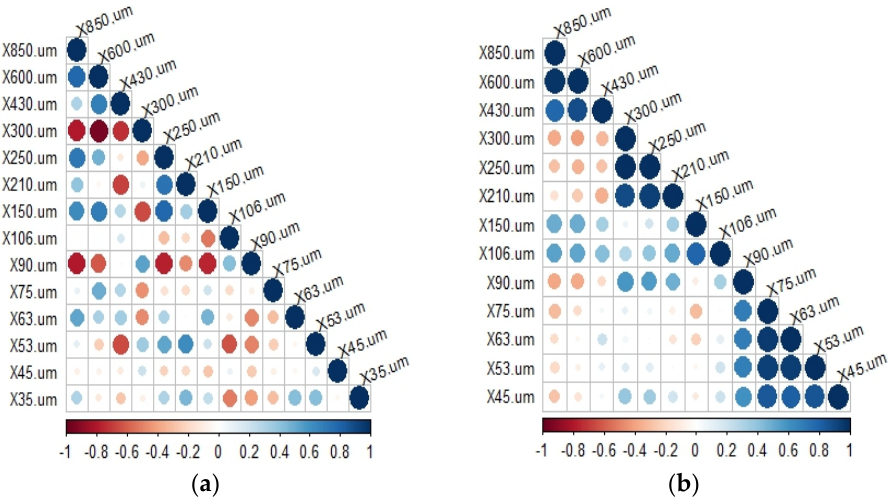
Figure 8. Cross-correlation analysis for 4 min grinding: ( a ) WPES and ( b ) PSD. Table 2. PSCP of the feed under different grinding times.